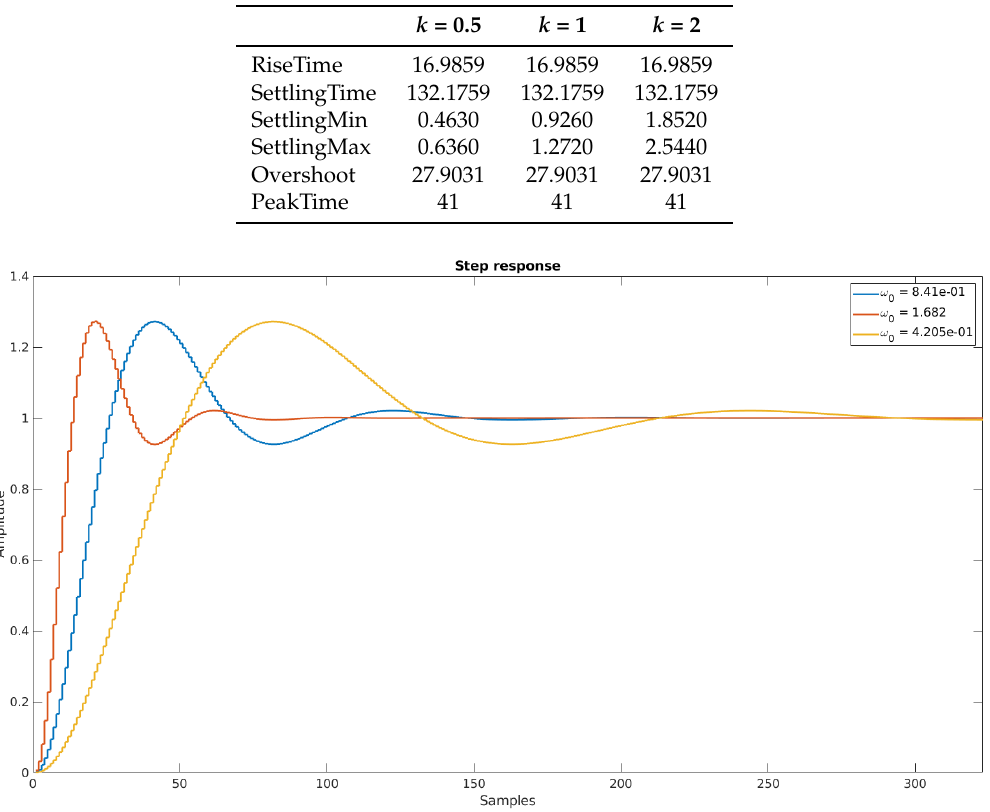
Figure 4. Comparison of the digital oscillatory system with ω 0 = 4.205 · 10 − 1 (orange), 8.41 · 10 − 1 (blue), and 1.682 (red); ζ =3.83 · 10 − 1 ; k =1; and t s = 1/10